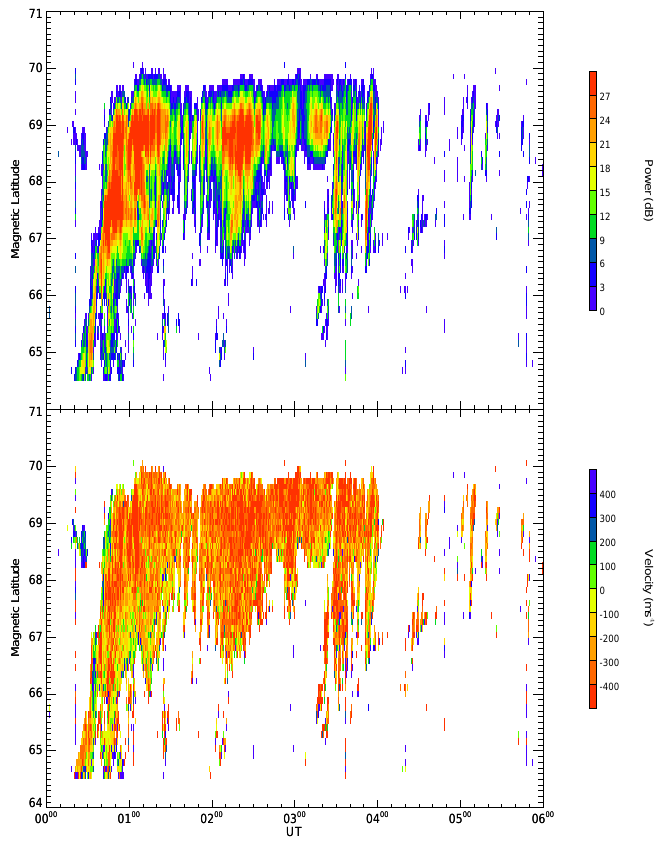
Fig. 16. Backscatter power (top panel) and velocity (lower panel) for the STARE Norway radar, beam 2, between 00:00UT and 06:00UT on 10 Decem- ber